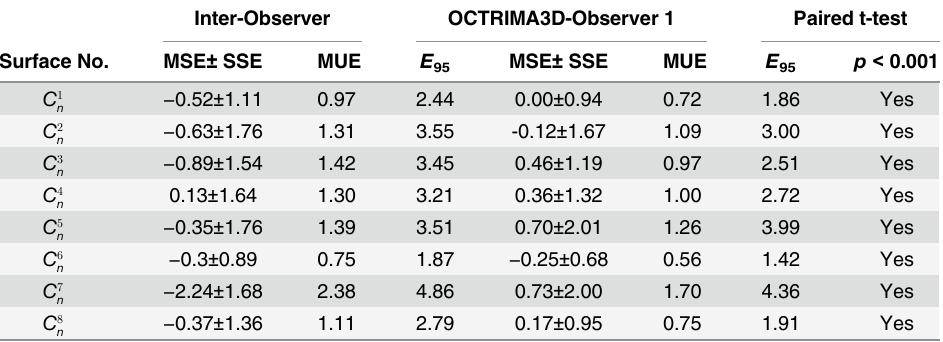
Table 4. Comparison results between OCTRIMA 3D and manual labelings from two graders. The man- ual labeling from Observer 1 is taken as the ground truth and the inter-observer difference is reported as a benchmark to evaluate the accuracy. The difference is evaluated using (MSE ± SSE, MUE, and E 95 ) in unit of pixels. Inter-Observer OCTRIMA3D-Observer 1 Paired t-test Surface No. MSE ± SSE MUE E 95 MSE ± SSE MUE p < 0.001 − 0.52 ± 1.11 C 1 n C 2 n − 0.89 ± 1.54 C 3 n C 4 n − 0.35 ± 1.76 C 5 n − 0.3 ± 0.89 C 6 n